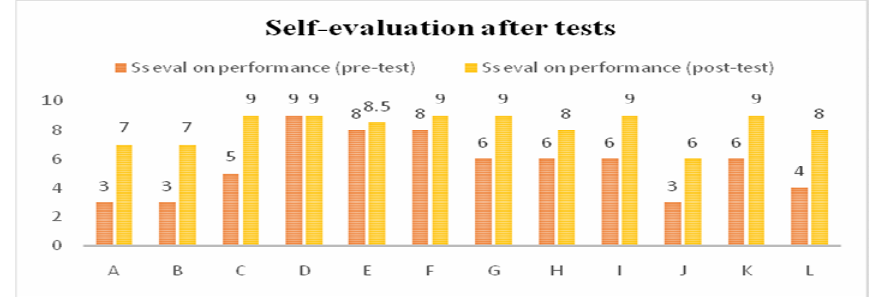
Figure 4. Ss self-evaluation results after pre and post-tests